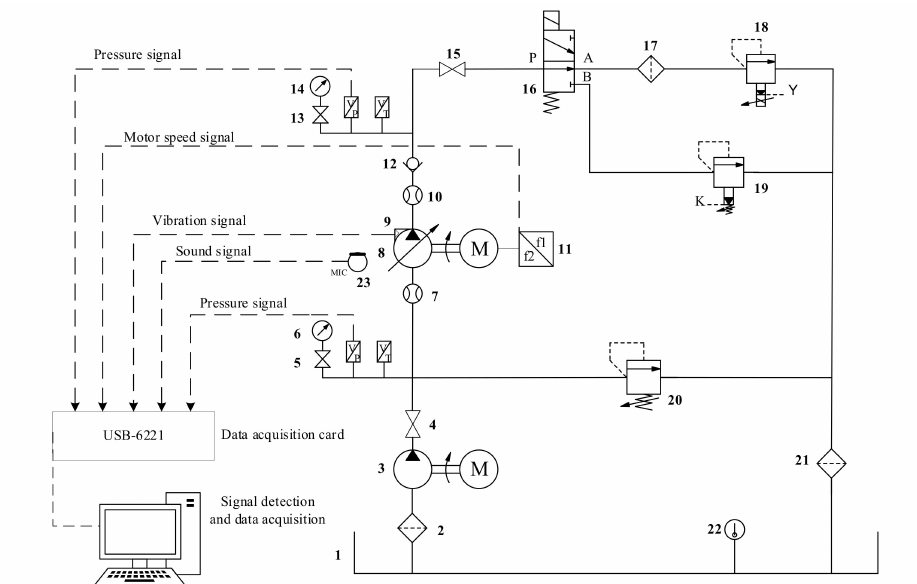
Figure 3. Schematic diagram of the test system. During the test, a data acquisition system was required to display and store the vibration signal collected by the vibration sensor in real-time [39]. The data acquisition system used in this test was based on the LabVIEW software (National Instruments (NI), Austin, Texas, USA). As shown in Figure 4, the sampling frequency, sampling time, and controls for starting and stopping the data collection could be set using the front panel. At the same time, the collected pump speed, pressure, vibration, and other information could be displayed in real-time.